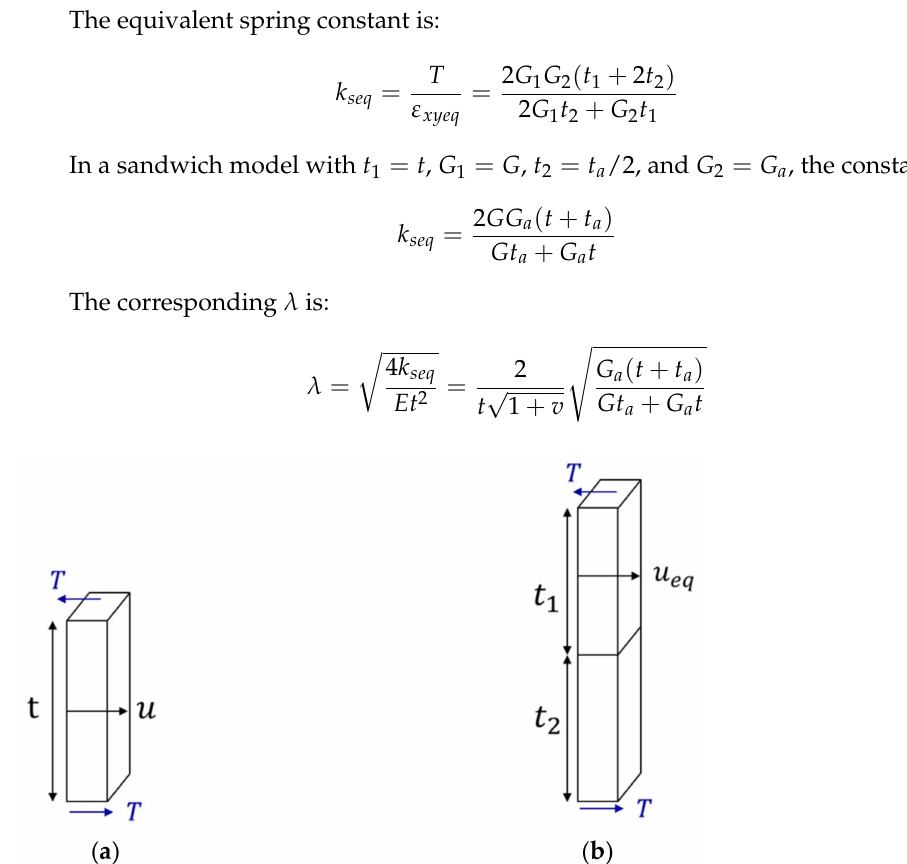
Figure A2. A diagram of determining the shear spring constant. ( a ) Isotropic beam; ( b ) Composite